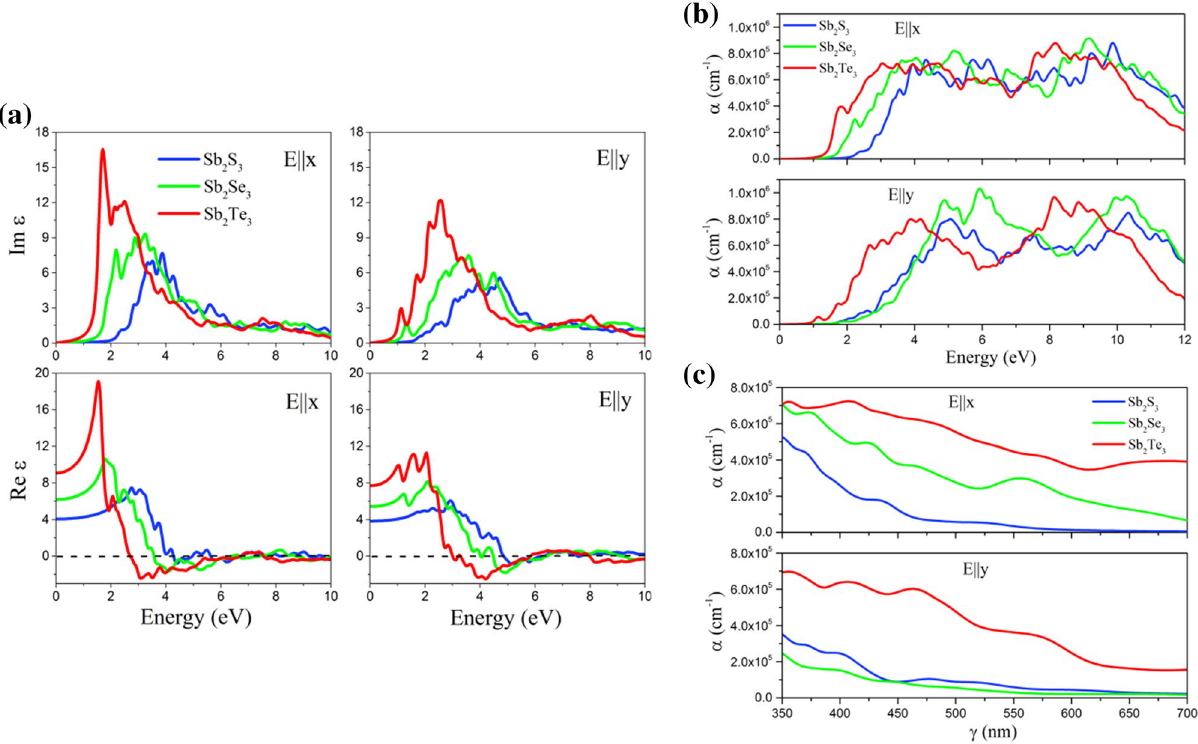
Figure 4. ( a ) Imaginary and real parts of the dielectric function as a function of photon energy of the Sb 2 S 3 , Sb 2 Se 3 and Sb 2 Te 3 monolayers for the in-plane polarizations ( E (cid:31) x and E (cid:31) y ), predicted using the RPA + HSE06 approach. Absorption coefficient as a function of ( b ) wavelength and ( c ) energy for the Sb 2 X 3 monolayers for the in-plane polarizations ( E (cid:31) x and E (cid:31) y ) in the UV–vis range of light, predicted using the RPA + HSE06